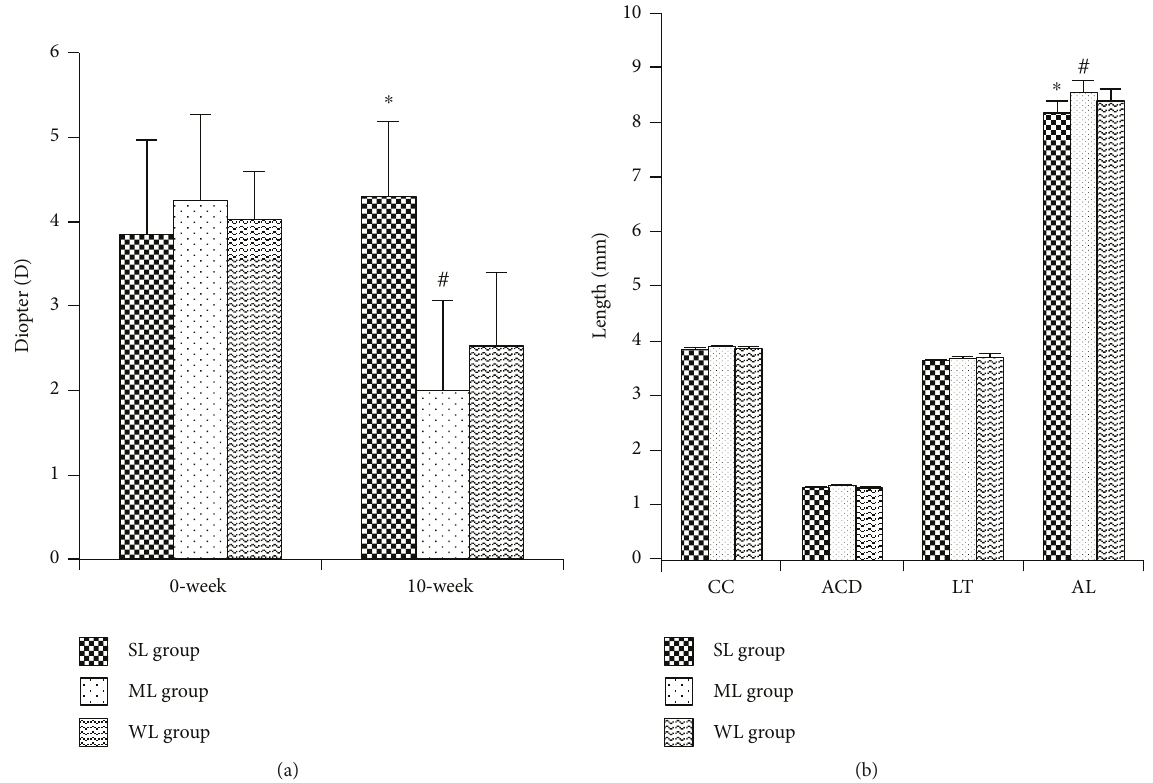
Figure 1: Biometric changes before and after intervention. Mean biometric results from guinea pigs reared under the three di ff erent lighting conditions (SL: short-wavelength light; ML: middle-wavelength light; WL: white light). (a) Diopters and (b) biometric results in 0-week and 10-week in the three groups. AL: axial length. ∗ means signi fi cant di ff erences between the SL and WL groups. # means signi fi cant di ff erences between the ML and WL groups.